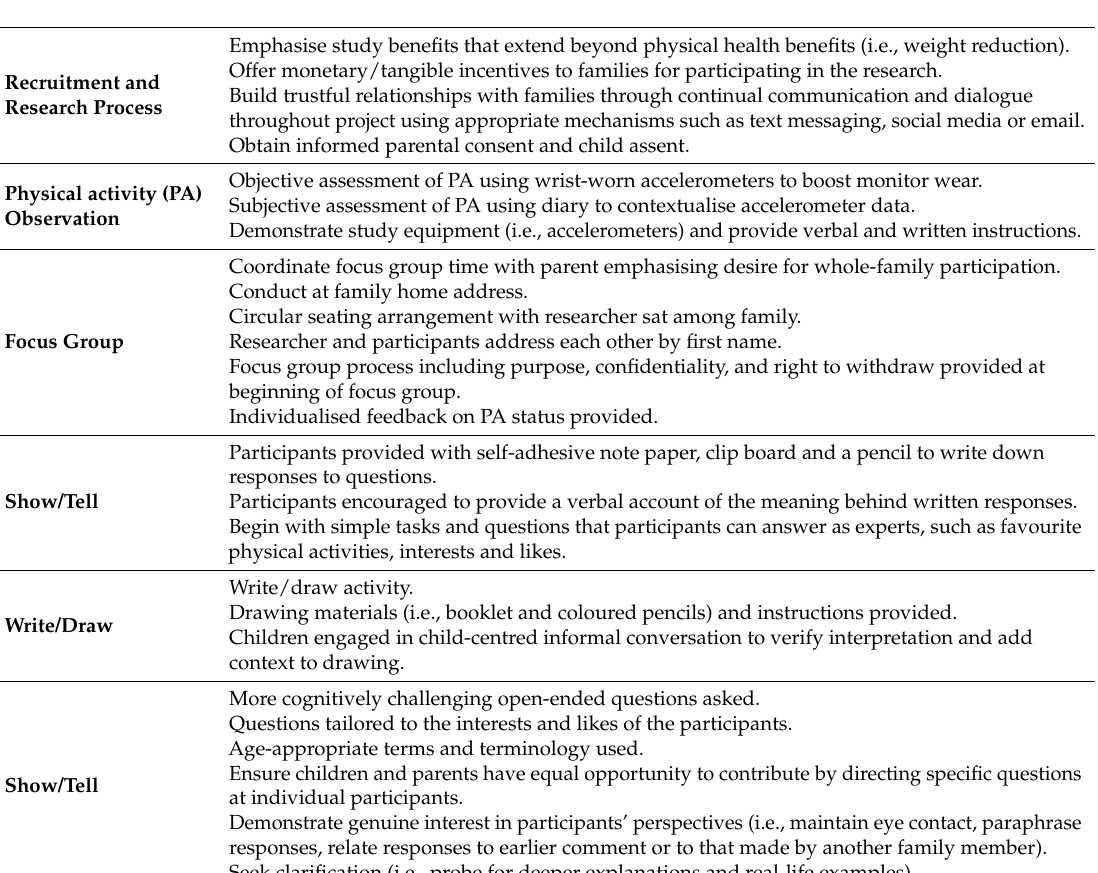
Table 1. Write, draw, show and tell (WDST) methodology and